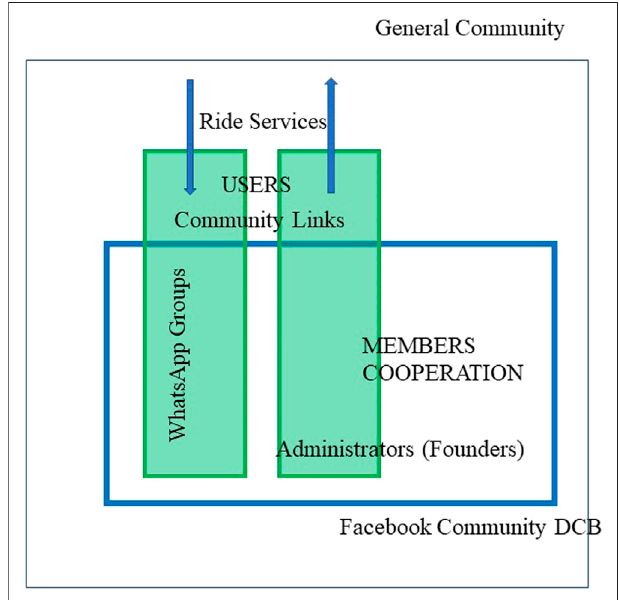
FIGURE 2 | Driver ’ s club Bogotá original heterarchy source: elaborated by the